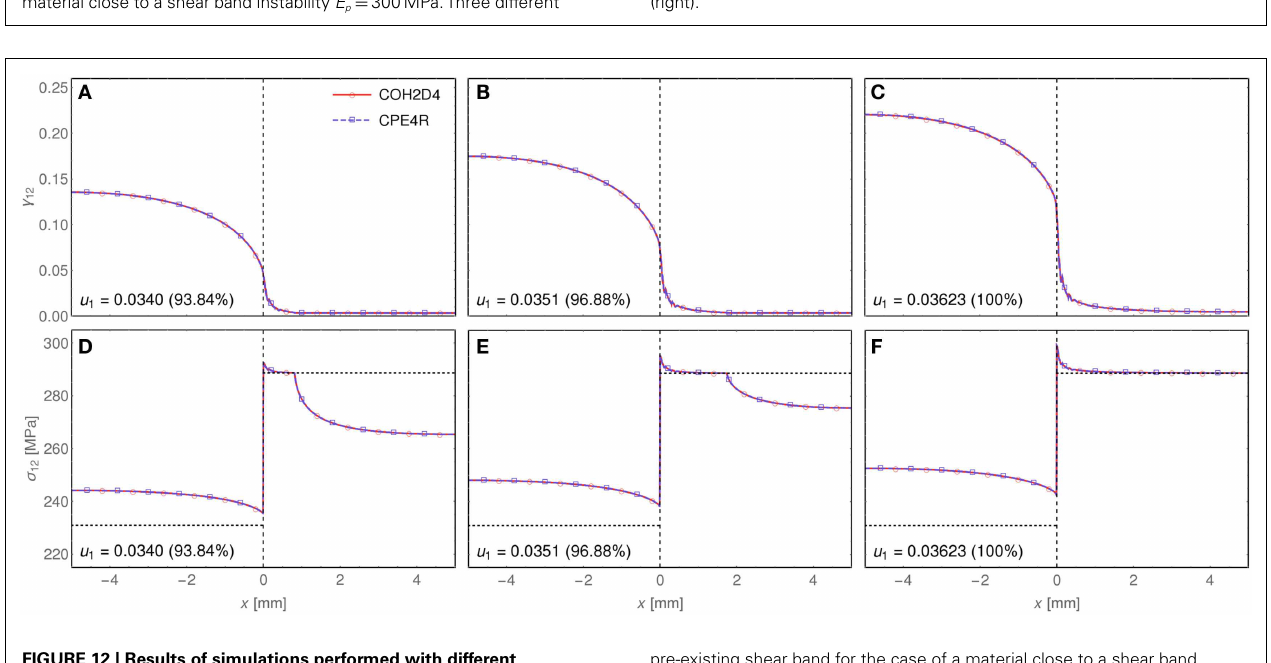
FIGURE 12 | Results of simulations performed with different idealizations for the shear band: zero-thickness model (discretized with cohesive elements, COH2D4) versus a true layer description (discretized with CPE4R elements) . Shear deformation γ 12 (A–C) and shear stress σ 12 (D–F) along the horizontal line y = 0 containing the